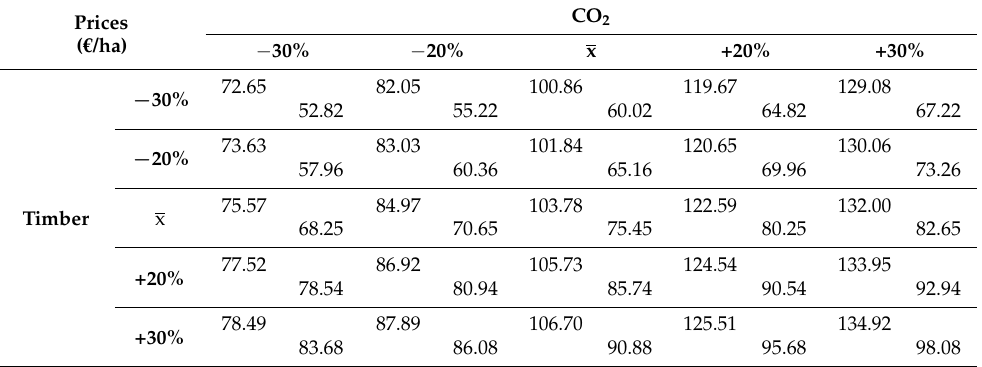
Table 3. Sensitivity analysis of scenarios. x means average